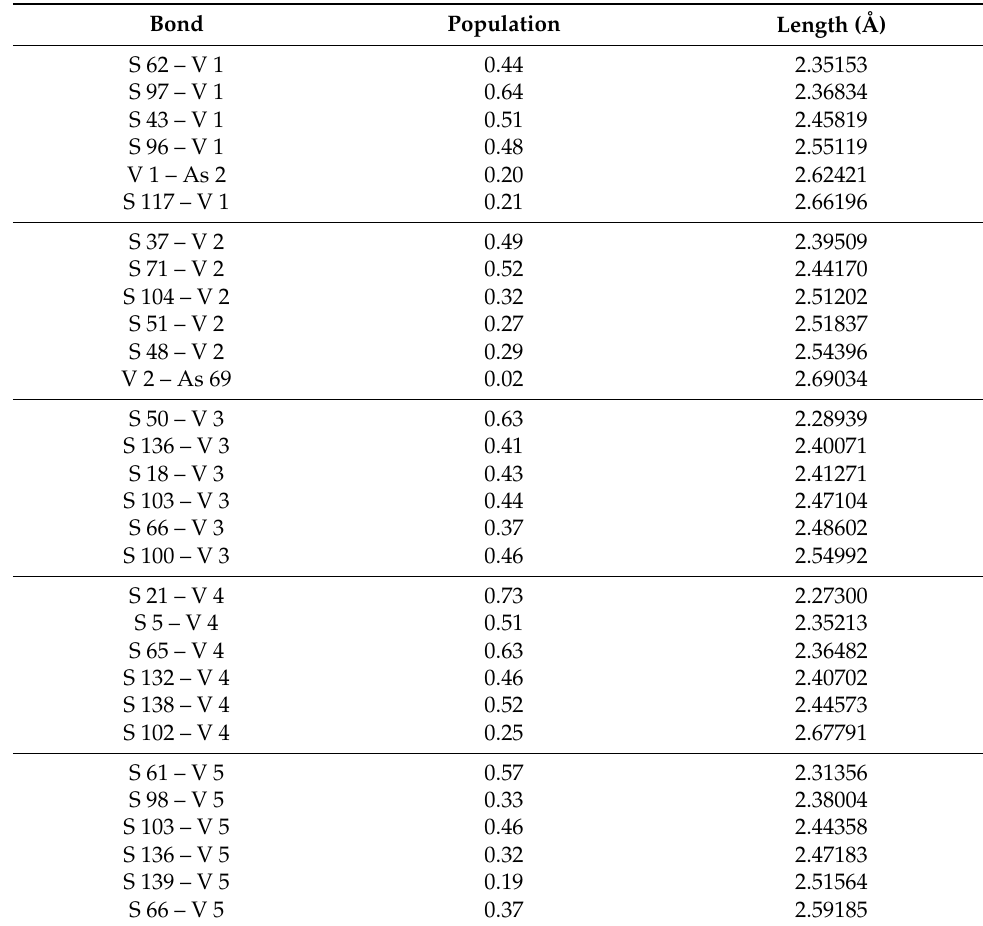
Table A9. Bond populations for mq As 2 S 3